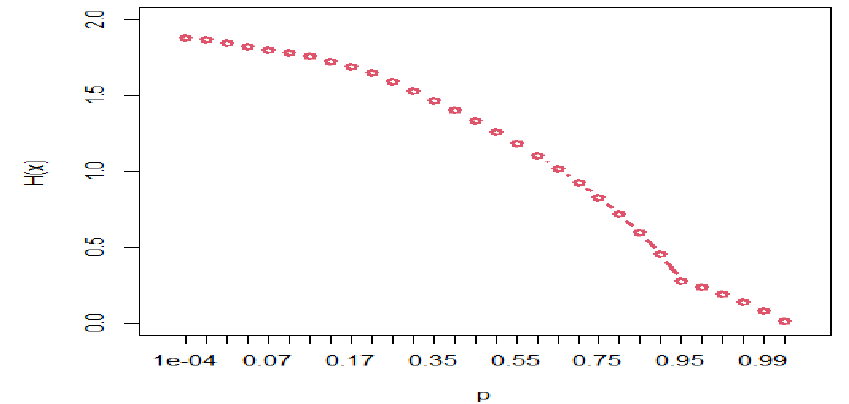
H ( X ) of X versus p Figure 5. ℍ(𝑋) of 𝑋 versus p . Figure 5.